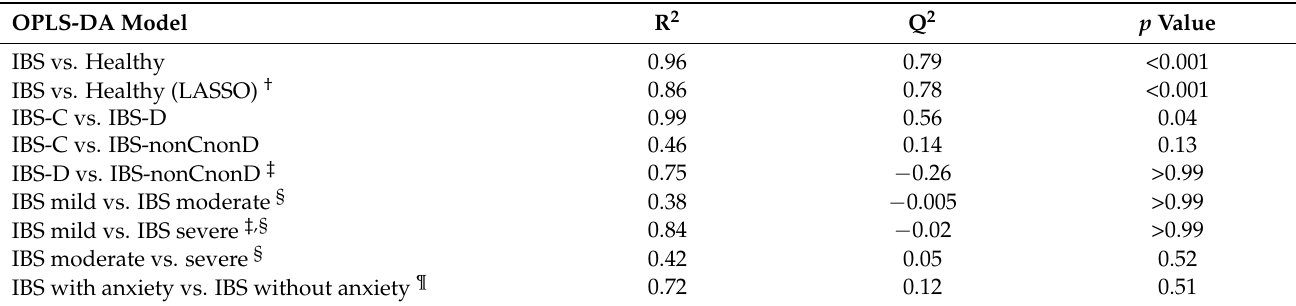
Table 2. Parameter values for orthogonal partial least squares-discriminant analysis (OPLS-DA) models. OPLS-DA